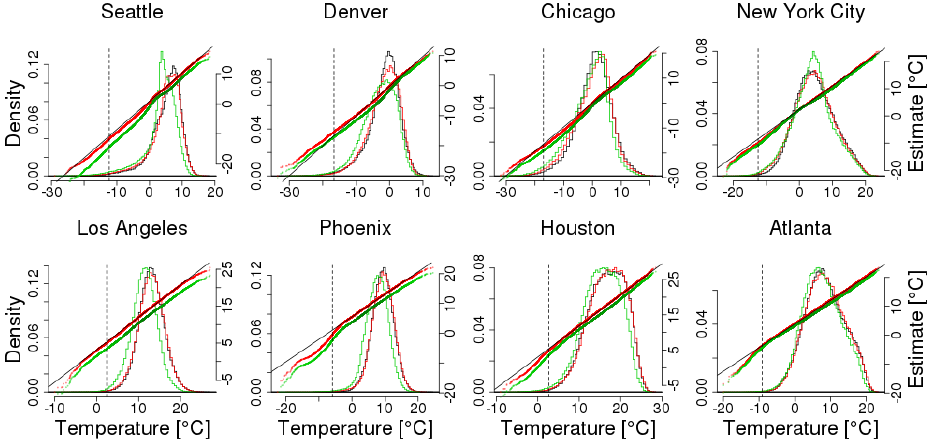
Figure A3. As in Fig. 10, only now we show all 40 simulations combined instead of a single simulation from each ensemble. The comparisons are now less affected by random noise and some features stick out more clearly, e.g., in Seattle or the mean shift between the projections in Los